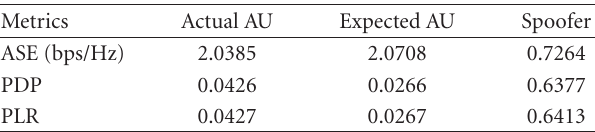
Table 2: System performance comparison between authorized and spoofer